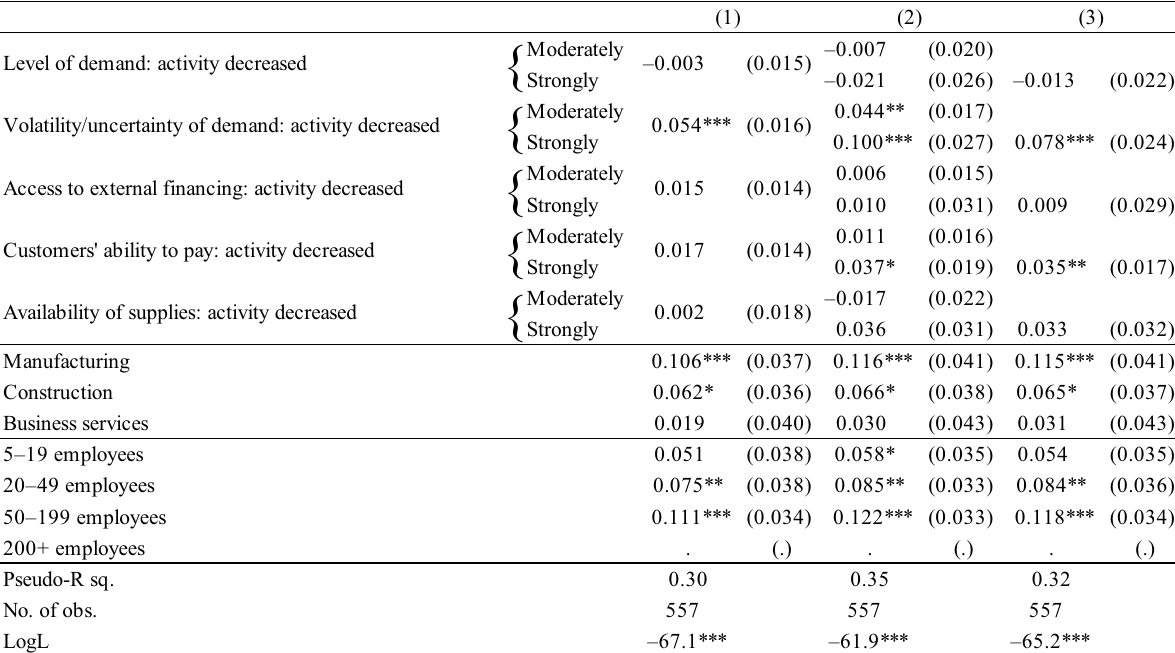
Table 11 Logit estimates for firms’ decision to apply for short‑time work in 2010–2013, marginal